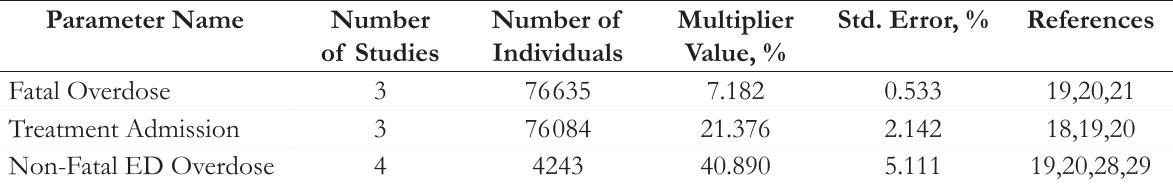
Table 2. Multiplier Data for Use in Individual Models